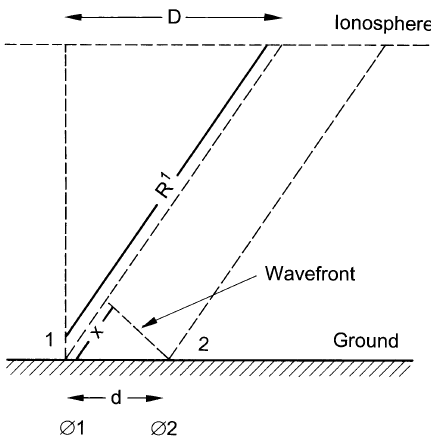
Fig. 2. Vertical section through diagonally opposite Dynasonde receiving antennas, for an echo received from a distance D from the zenith (after Dudeney and Jarvis,